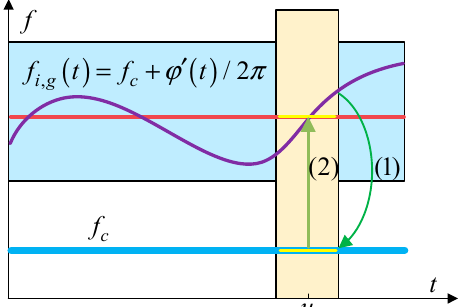
Figure 1 . Description of demodulation procedure (Purple line: instantaneous frequency of the original FM signal; red line: instantaneous frequency of the forward demodulated signal; blue line: instantaneous frequency of the backward modulation signal.). Before demodulation, the spectrum of original signal is distributed around the frequency f c + ϕ (cid:48) ( u ) /2 π